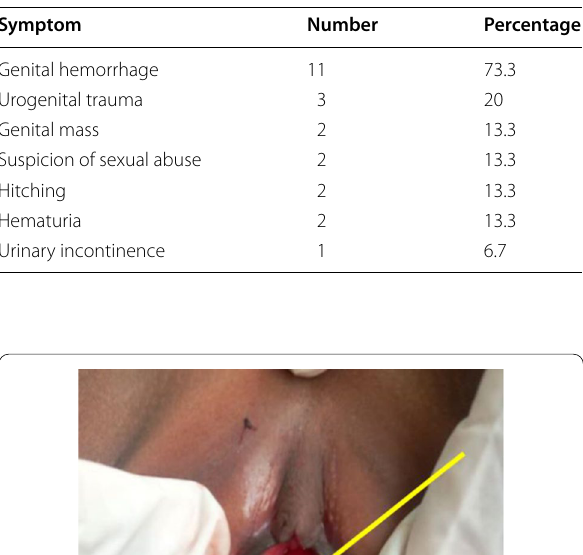
Table 1 Symptoms of urethral prolapse found in patients